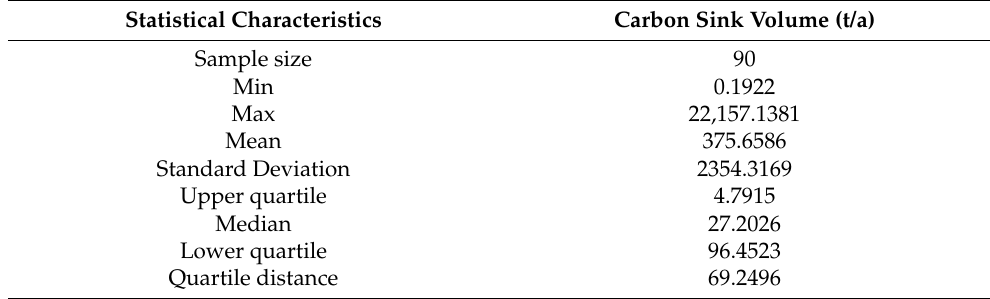
Table 4. Statistical characteristics of in each carbon sink of urban green space in central